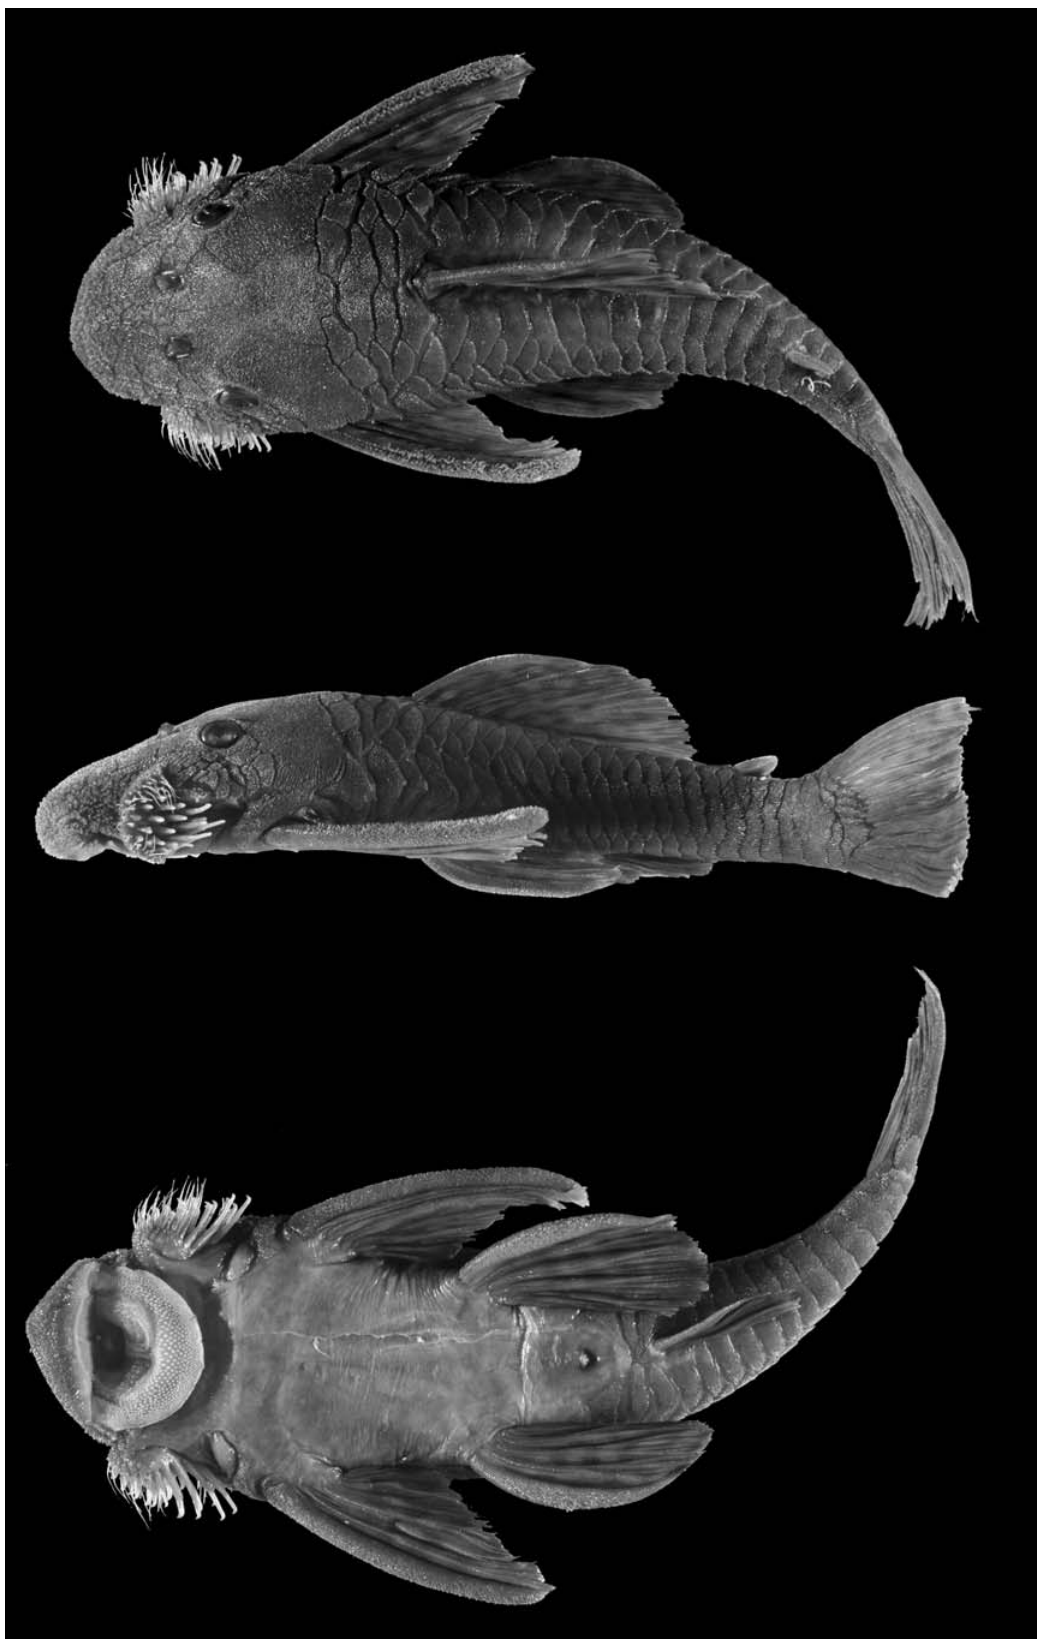
Fig. 9. Dorsal, lateral, and ventral views of holotype of Lasiancistrus tentaculatus , MCNG 19744, 147.6 mm